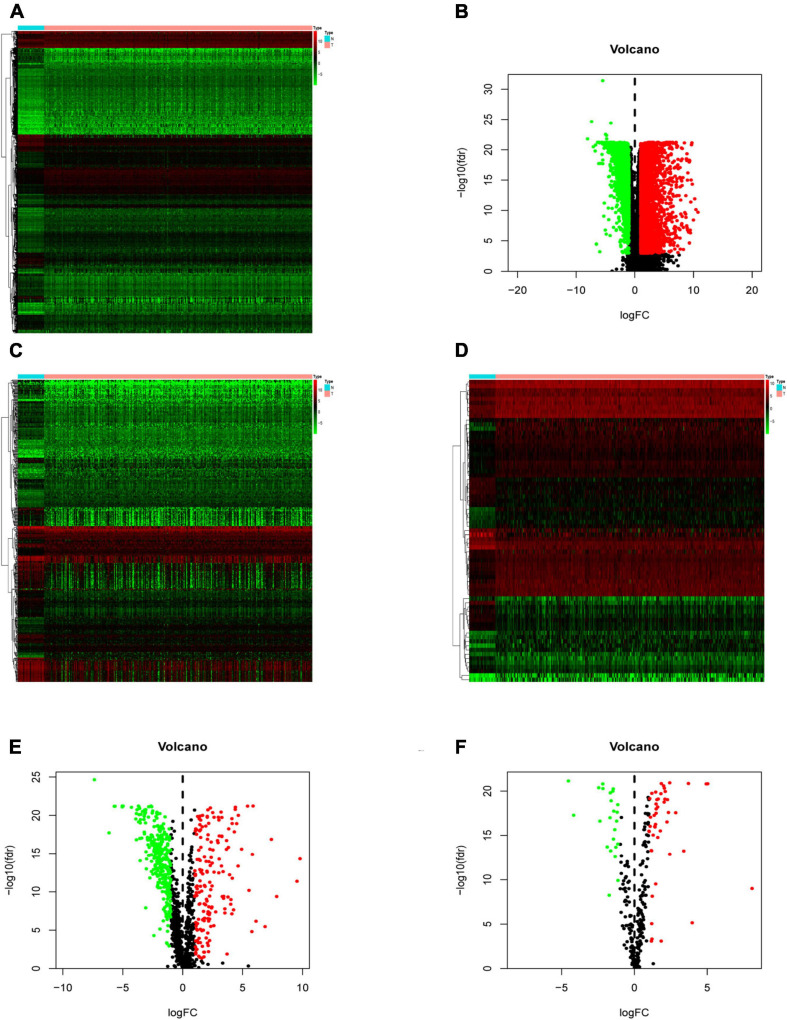
Differentially expressed immune-related genes (IRGs) and cancer-related transcription factors (CRTFs) in colorectal cancer (CRC). (A) Heatmap of differentially expressed genes in CRC. The color from green to red represents the progression from low expression to high expression. (B) Volcano plot of differentially expressed genes in CRC. The red dots in the plot represent upregulated genes, and green dots represent downregulated genes with statistical significance. Black dots represent no differentially expressed genes in CRC. (C) Heatmap of significantly differentially expressed IRGs in CRC. (D) Heatmap of significantly differentially expressed cancer-related transcription factors in CRC. The color from green to red represents the progression from low expression to high expression. (E) Volcano plot of differentially expressed IRGs. (F) Volcano plot of differentially expressed cancer-related transcription factors.